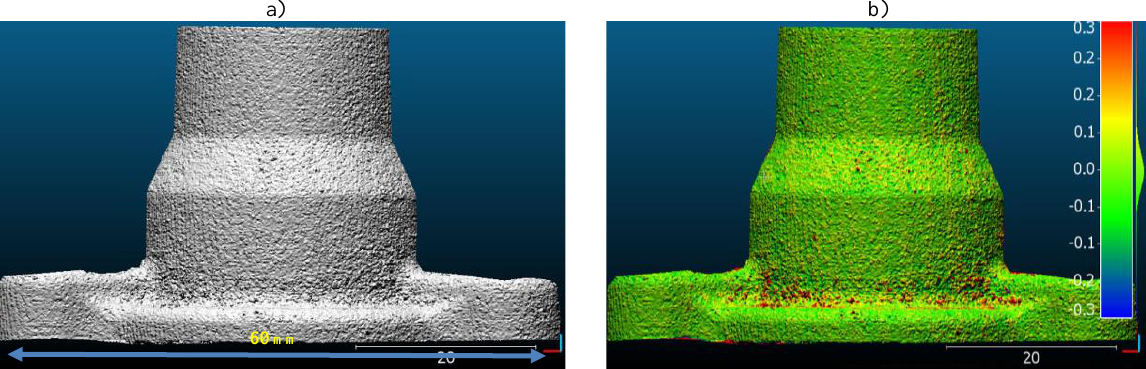
Figure 9. The merged point clouds from the different grazing angles (a). The result of the point-to-point comparison with reference data (b): the estimated RMS of Euclidean distances is 0.063mm, i.e. almost the average of the RMS obtained with the individual 3D point clouds derived under different grazing angles (Figure